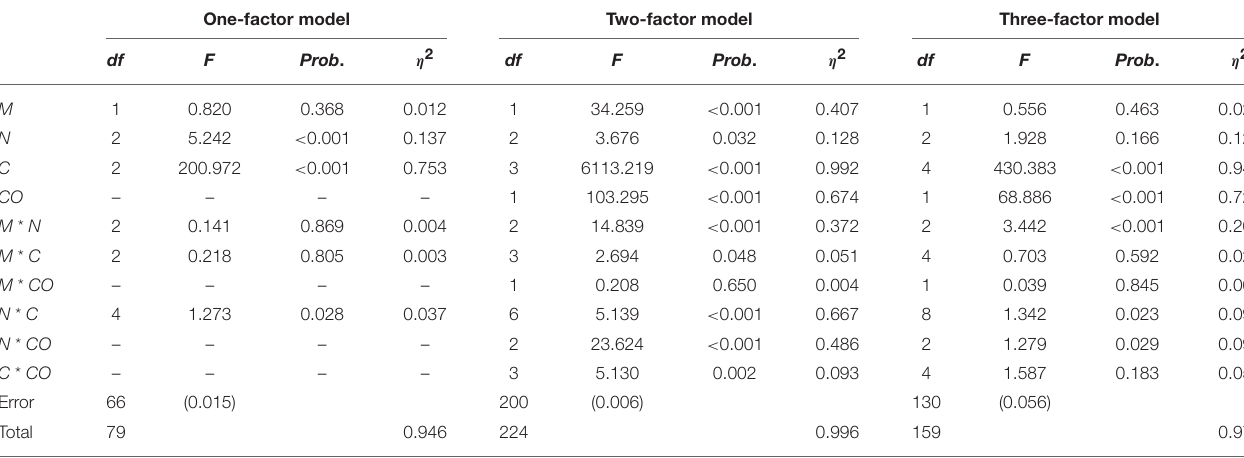
TABLE 4 | ANOVA Results for the ARE measure in the Monte Carlo study. One-factor model Two-factor model Three-factor model